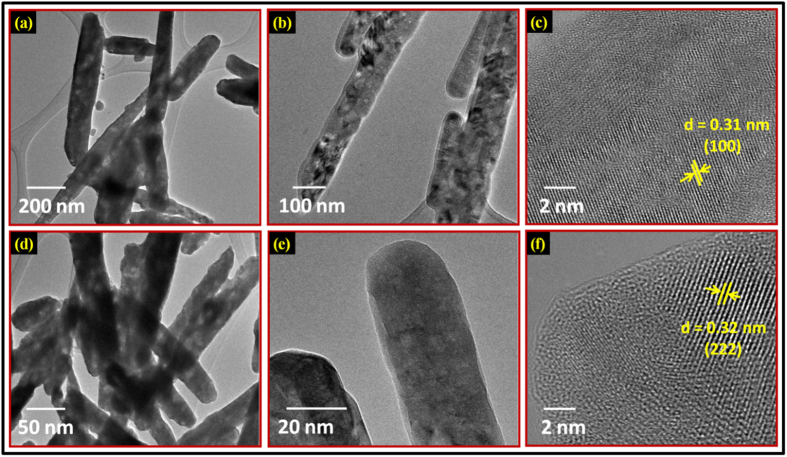
(a) TEM image of as-synthesized Gd0.925Eu0.075(OH)3 nanophosphor. (b) Magnified view of Fig. (a) (c) HRTEM image of as-synthesized Gd0.925Eu0.075(OH)3 nanophosphor. (d) TEM image of as-synthesized Gd1.85Eu0.15O3 nanorods. (e) Magnified view of Fig. (d). (f) HRTEM image of as-synthesized Gd1.85Eu0.15O3 nanorods.